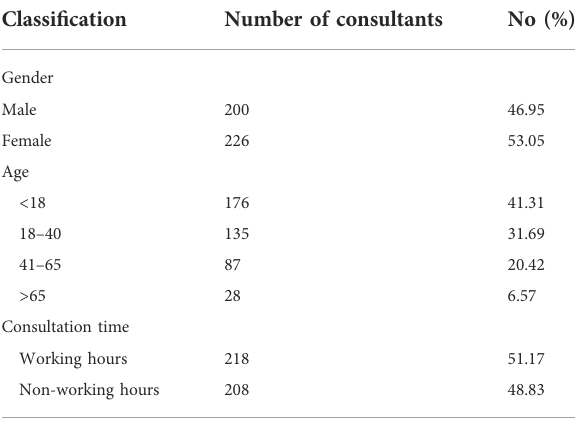
TABLE 2 Basic information of the medication consultants.